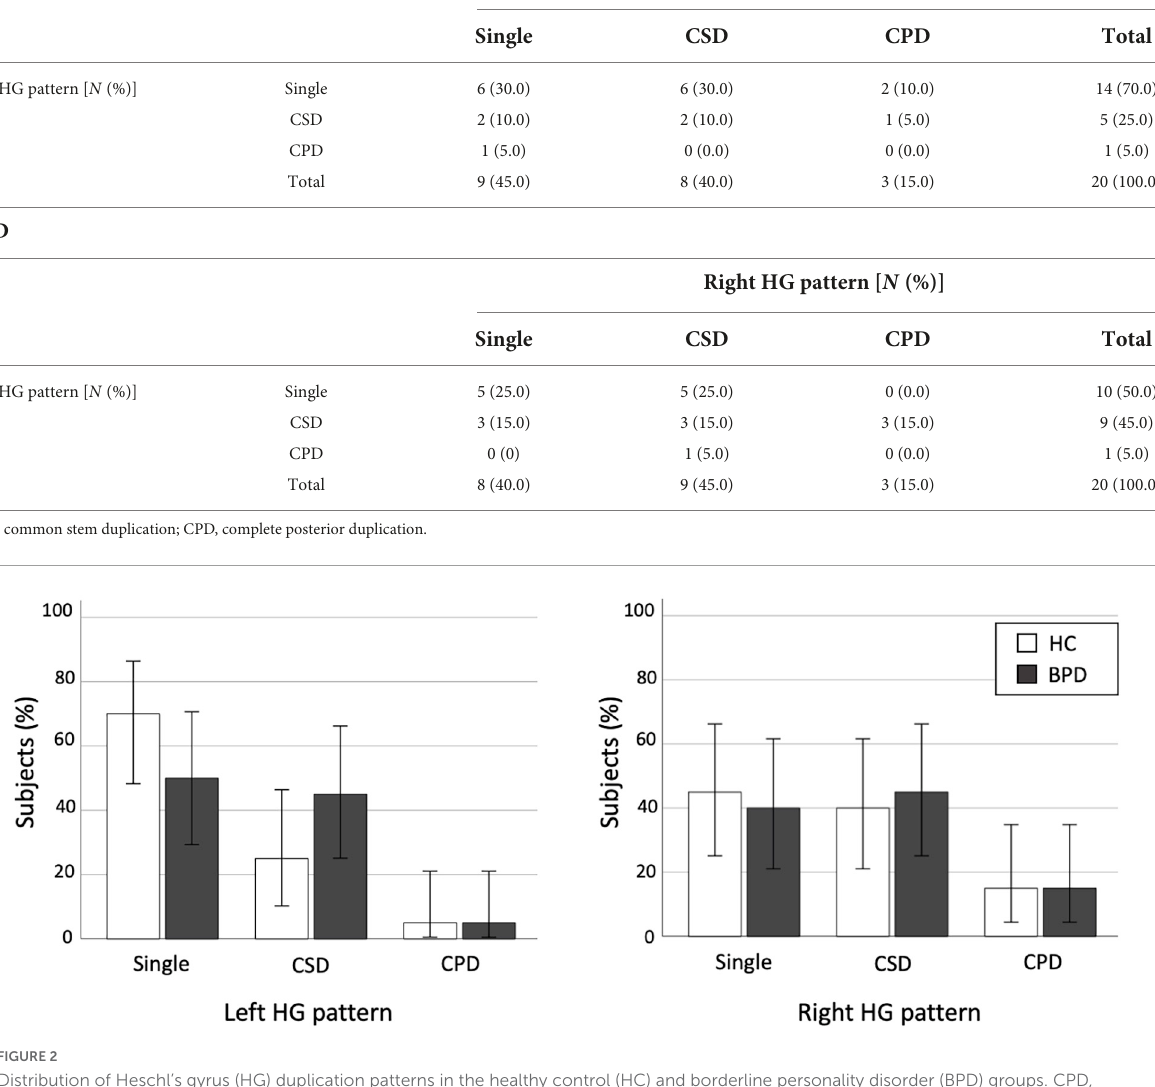
Right HG pattern [ N (%)]